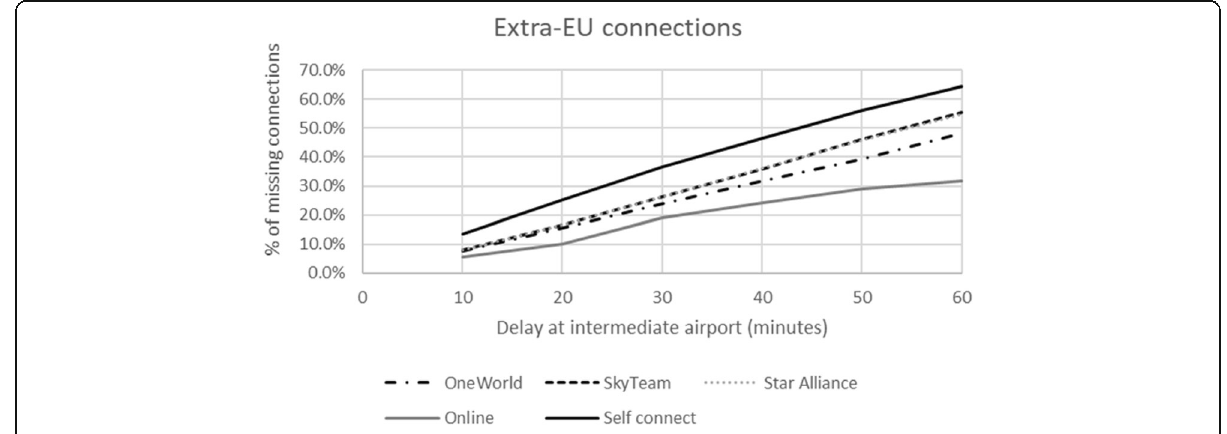
Fig. 2 Percentage of missed connections to extra-EU destinations related to delayed arrivals at the intermediate airports